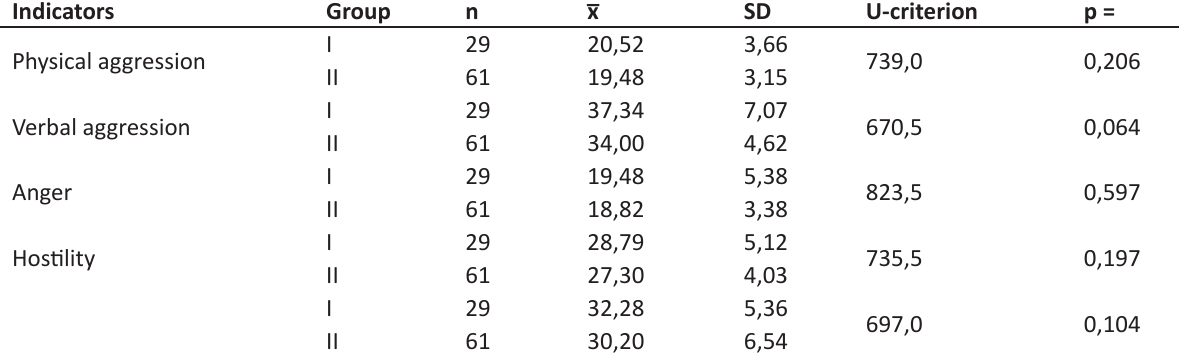
Table 4. Aggression and self assessment indicators depending on sportsmanship of the tested (points) Indicators